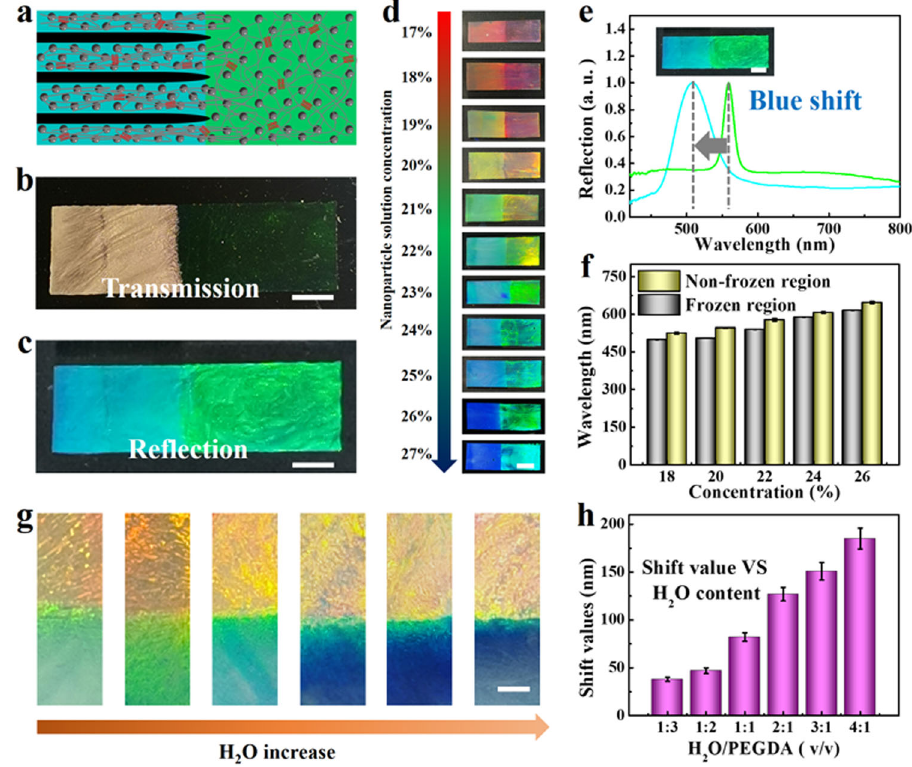
Fig. 4 Wavelength blue-shift induced by freezing. a Schematic illustration of dual-color ice-templated fi lm. b , c The transmission image ( b ) and re fl ection image ( c ) of a dual color heterogeneous II-TSCHF. The right part is nonfrozen zone and the left part is frozen zone. The subcooling is 7.9 K. The v/v ratio of H 2 O/PEGDA was 1:1. A pregel suspension with nanoparticles solution concentration of 23 % was used. Nanoparticles with a diameter of 145 nm were employed. d Optical images of dual color heterogeneous II-TSCHF with different nanoparticles solution concentration. The v/v ratio of H 2 O/PEGDA was 1:2. The subcooling is 9.2 K. Nanoparticles with a diameter of 145 nm were employed. e Re fl ection spectrum of the heterogeneous structural color hydrogel corresponding to ( c ). f Re fl ection peak wavelengths of various dual color heterogeneous structural color hydrogels with different nanoparticle solution concentration corresponding to ( d ). g Optical images of the dual color heterogeneous hydrogel fi lms of different liquid water content in colloidal suspensions. The upper part is nonfrozen zone and the lower part is frozen zone. The subcooling is 13.4 K. A suspension with nanoparticles solution concentration of 20% was used. h Relationships between shift values of heterogeneous structural color fi lms and different liquid water content in colloidal suspensions, in which case the subcooling is 13.4 K. The error bars represent the standard deviations derived from at least three specimens. Scale bars are 2 mm in ( b – e ), 1 mm in ( g